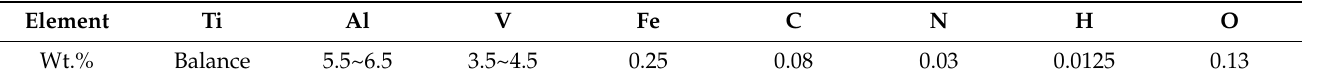
Figure 1. SEM morphology of TC4 titanium alloy powder particles. Table 1. Chemical composition of TC4 titanium alloy powder.